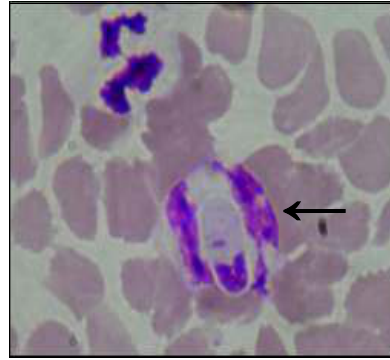
Figure-2. Babesia canis pear shaped merozoites in pairs